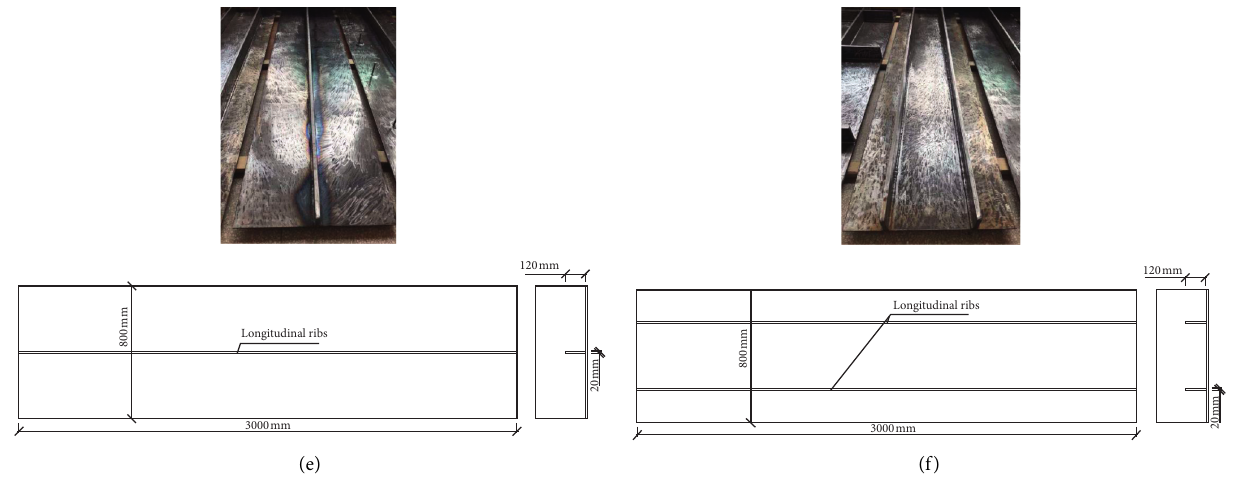
Figure 4: Photographs of the specimen: (a) SP1, (b) SP2, (c) SP3, (d) SP4, (e) SP5, and (f)